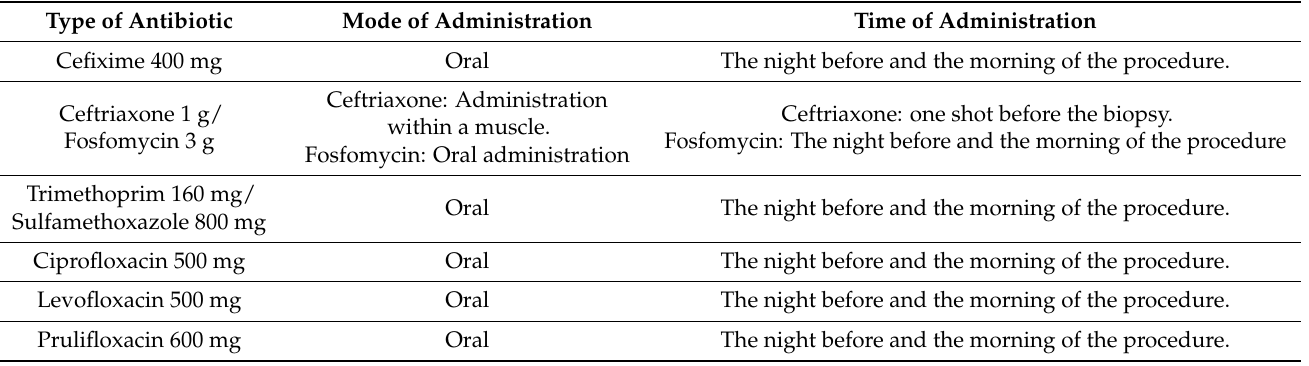
Table 4. Dose, mode and time of administration of antibiotic